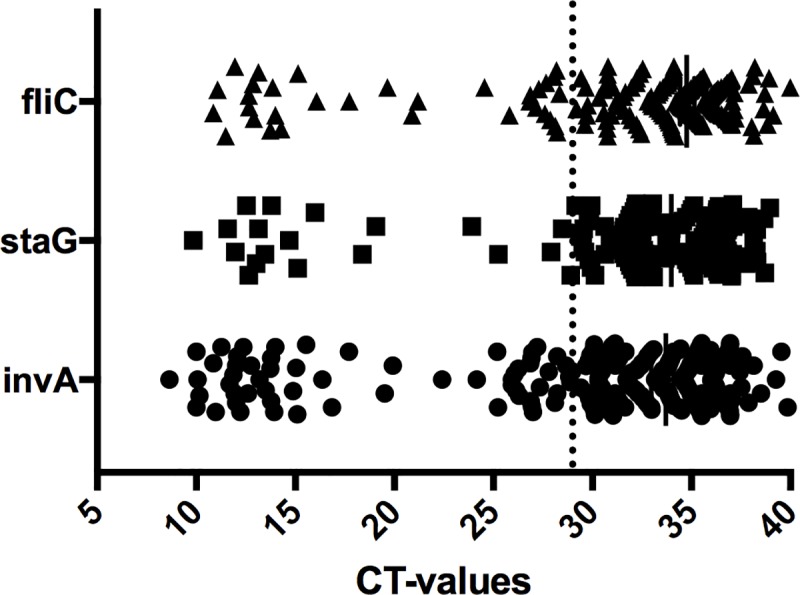
Bimodal distribution of CT-values for primers invA, fliC and staG.Graph shows the distribution of CT-values for the salmonella pan primer and S.Typhi and S.Typhiurium specific primers with a clear distinction between PCR positives and negatives.